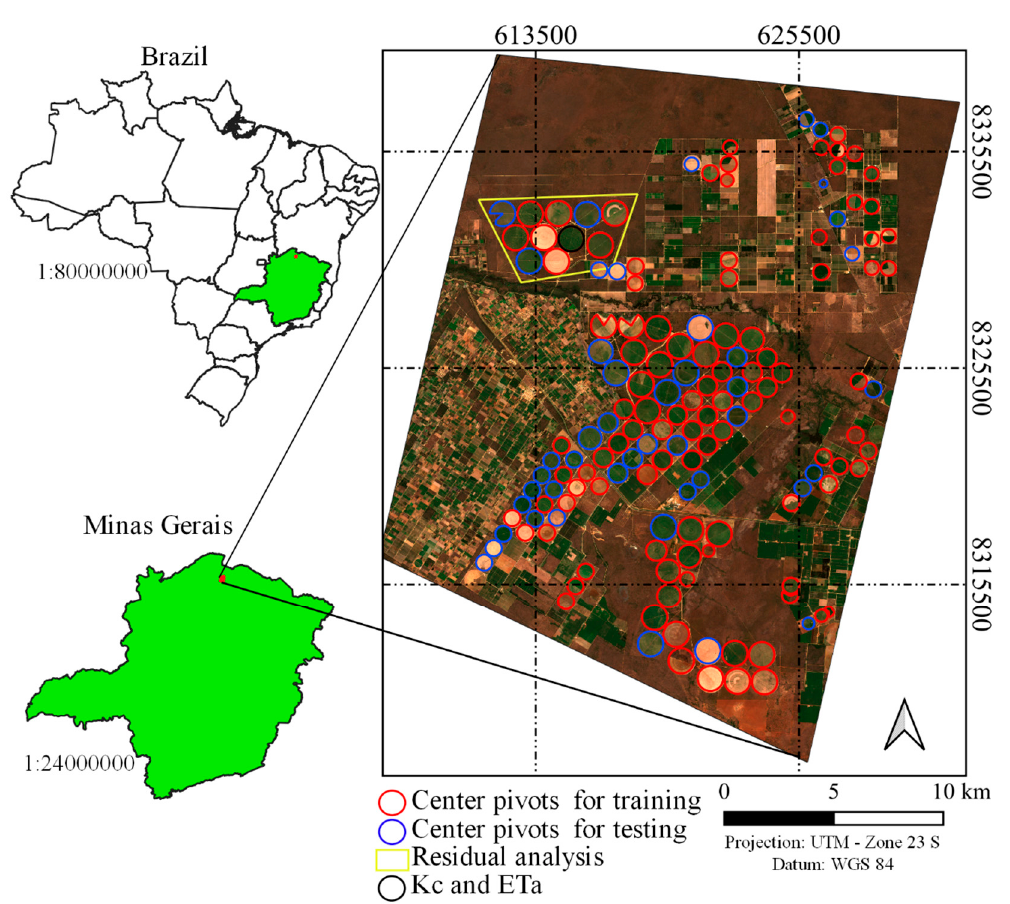
Figure 1. Location of the study area with the central pivots used for training, testing, and applying the models